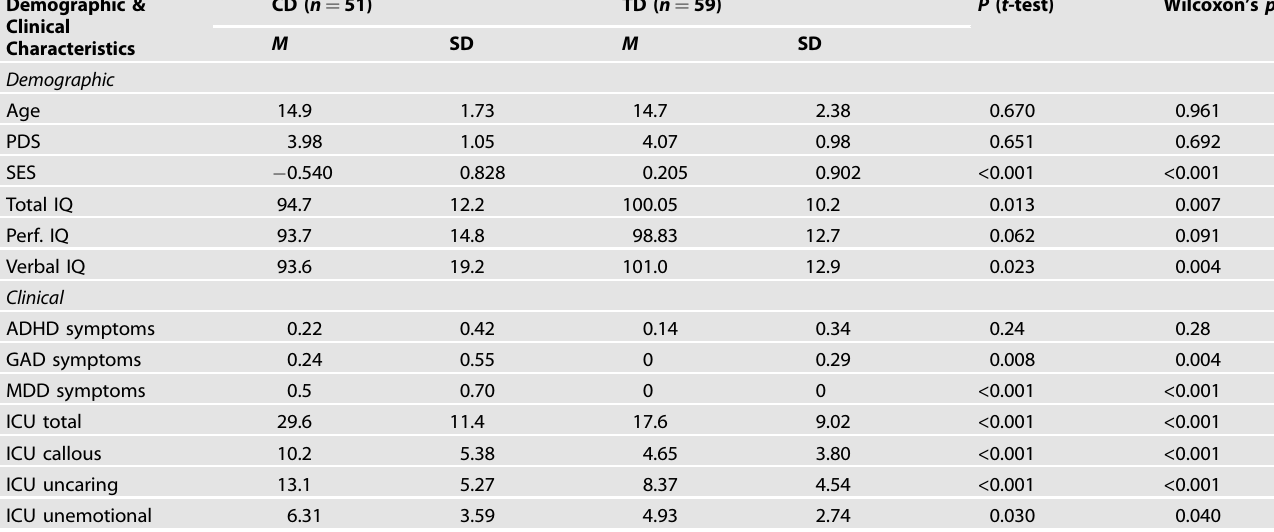
Table 1. Demographic and clinical characteristics of the